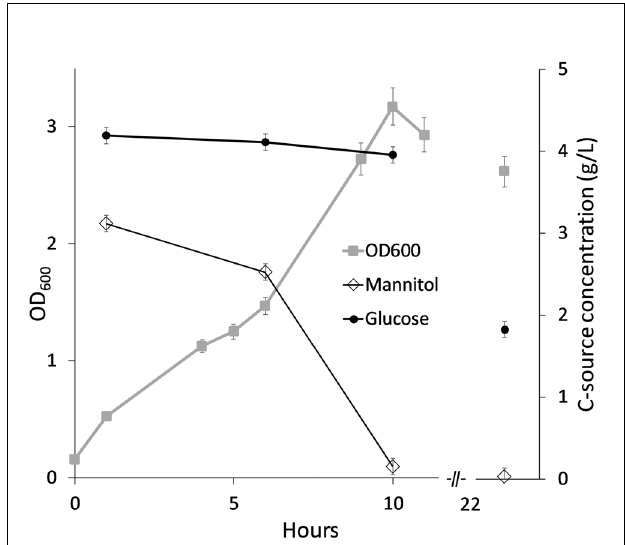
FIGURE 4 | Bacillus methanolicus MGA3 cultivated in SWE2 20 medium with hydrolyzed laminaran. Consumption of mannitol and glucose was measured over time and shown as remaining sugar in culture medium. Maximum deviation for triplicate cultivations is presented.